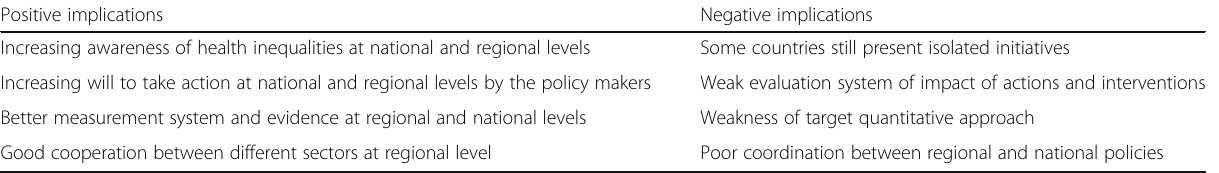
Table 5 Positive and negative implications of the survey Positive